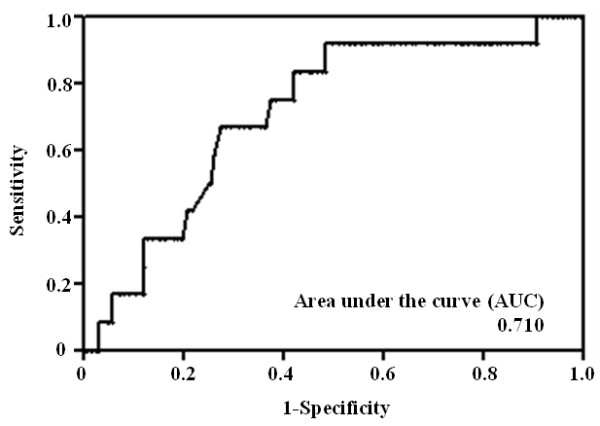
Receiver operating characteristic curve for serum sialyl Lewis X (SLX) in pathological (p)N0 and skip N2 patients. The area under the curve (AUC) = 0.710. The calculated optimal cutoff point for serum SLX concentration was 21.4 U/mL (Youden index = 0.433), and the sensitivity was 91.7% (11 of 12 skip N2 patients), whereas the specificity was 51.7% (109 of 211 pN0 patients).